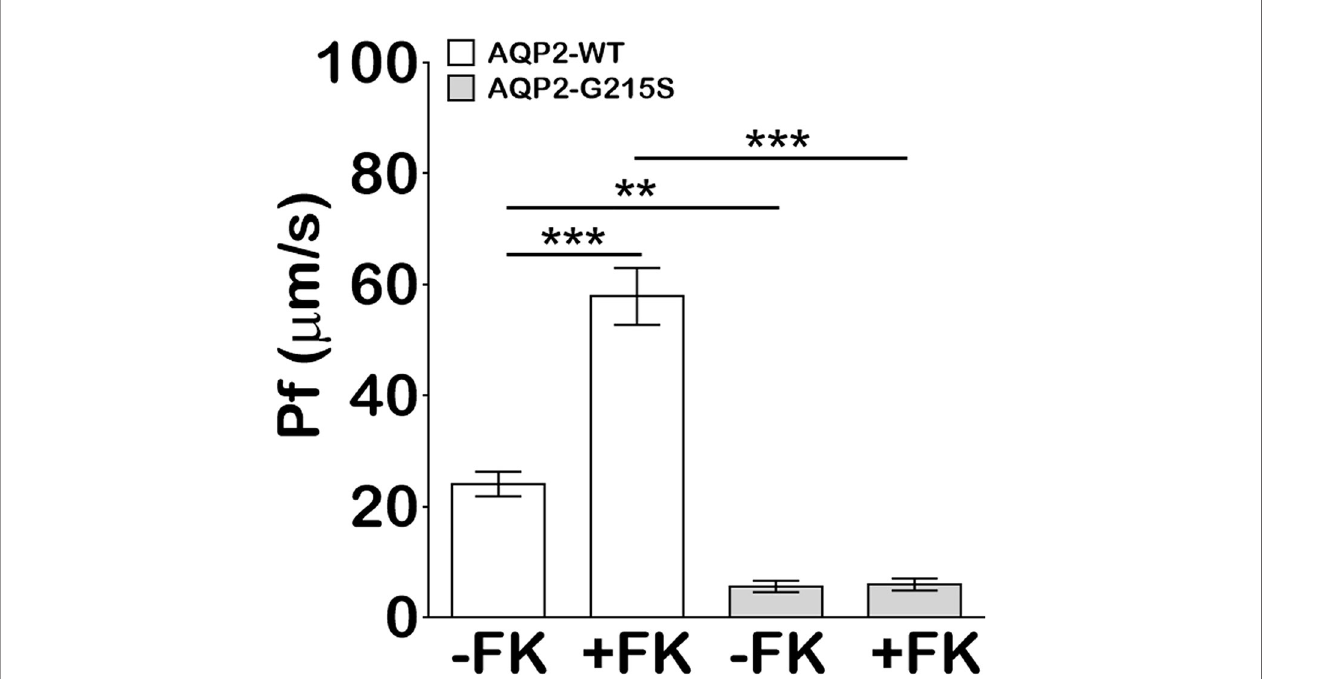
FIGURE 3 | MDCK cells transfected with AQP2-G215S displayed impaired transcellular osmotic water permeability. Cells were seeded onto 0.33 cm 2 polycarbonate fi lters, and replaced with fresh medium in the presence of 5 × 10 − 5 M indomethacin. Osmotic water transport was assayed with or without 5 × 10 − 5 M forskolin. The osmotic water transport (Pf) of AQP2-G215S-transfected and AQP2-WT-transfected cells was calculated as described in Material and Methods. WT, wild type; FK, Froskolin. Data were shown as mean ± SEM. n = 3, ** p < 0.01, *** p <